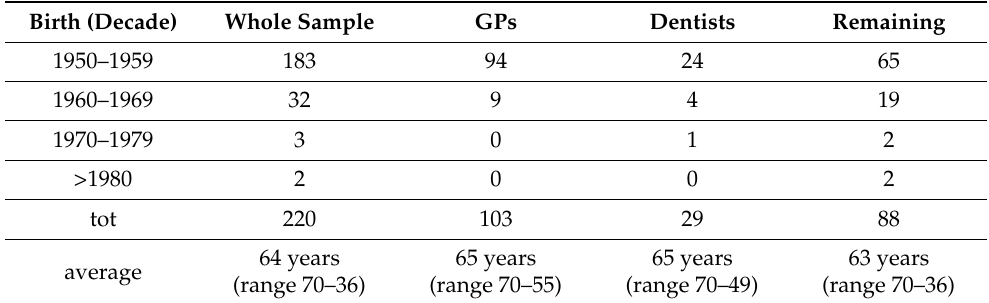
Table 2. Age distribution of the whole sample, GPs, dentists and remaining doctors, excluding subjects > 70 years and those with unknown age.